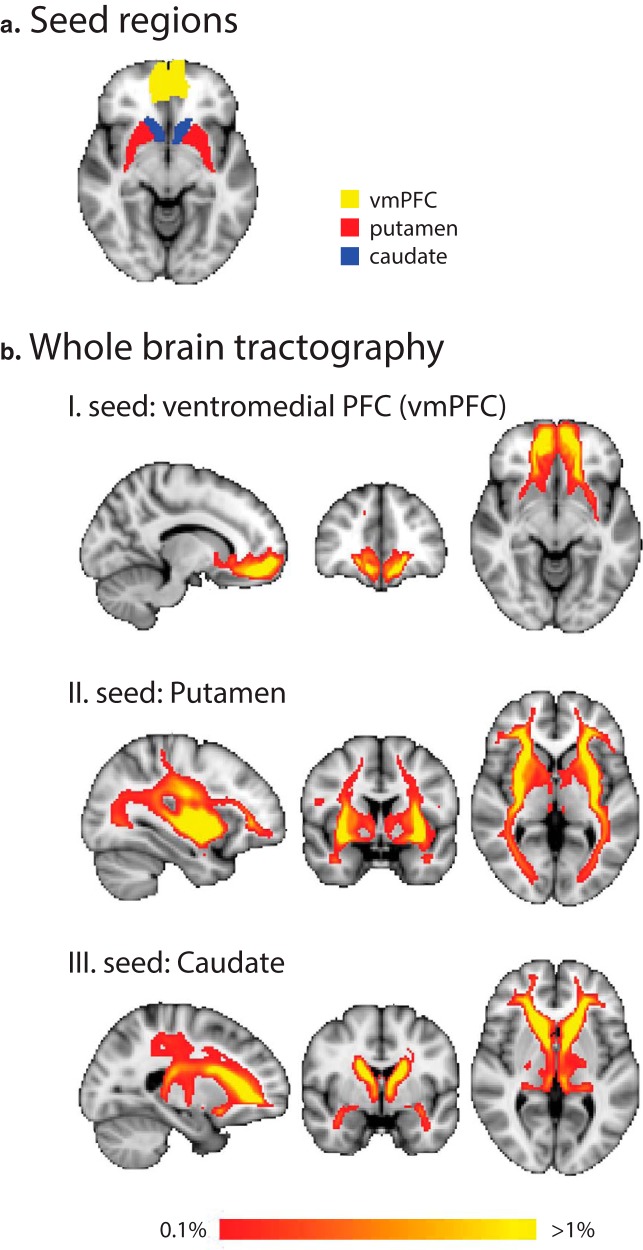
Seed regions and connection probability maps. A, Seed regions for probabilistic tractography overlaid on the MNI template (z = -8). B, Connection probability maps for each seed region (vmPFC, putamen, caudate). Maps (radiologic convention: left is right) are thresholded at 0.1% of total tracts per seed and are averaged for pre- and post-training sessions and across participants. Results are displayed in MNI for I, vmPFC (x = -12, y = 40, z = -8); II, putamen (x = -32, y = 2, z = 2); and III, caudate (x = -22, y = -2, z = 4) as seeds. Whole-brain tractography was computed separately for the left and right hemisphere and for pre- and post-training sessions, and the maps were combined for visualization purposes.